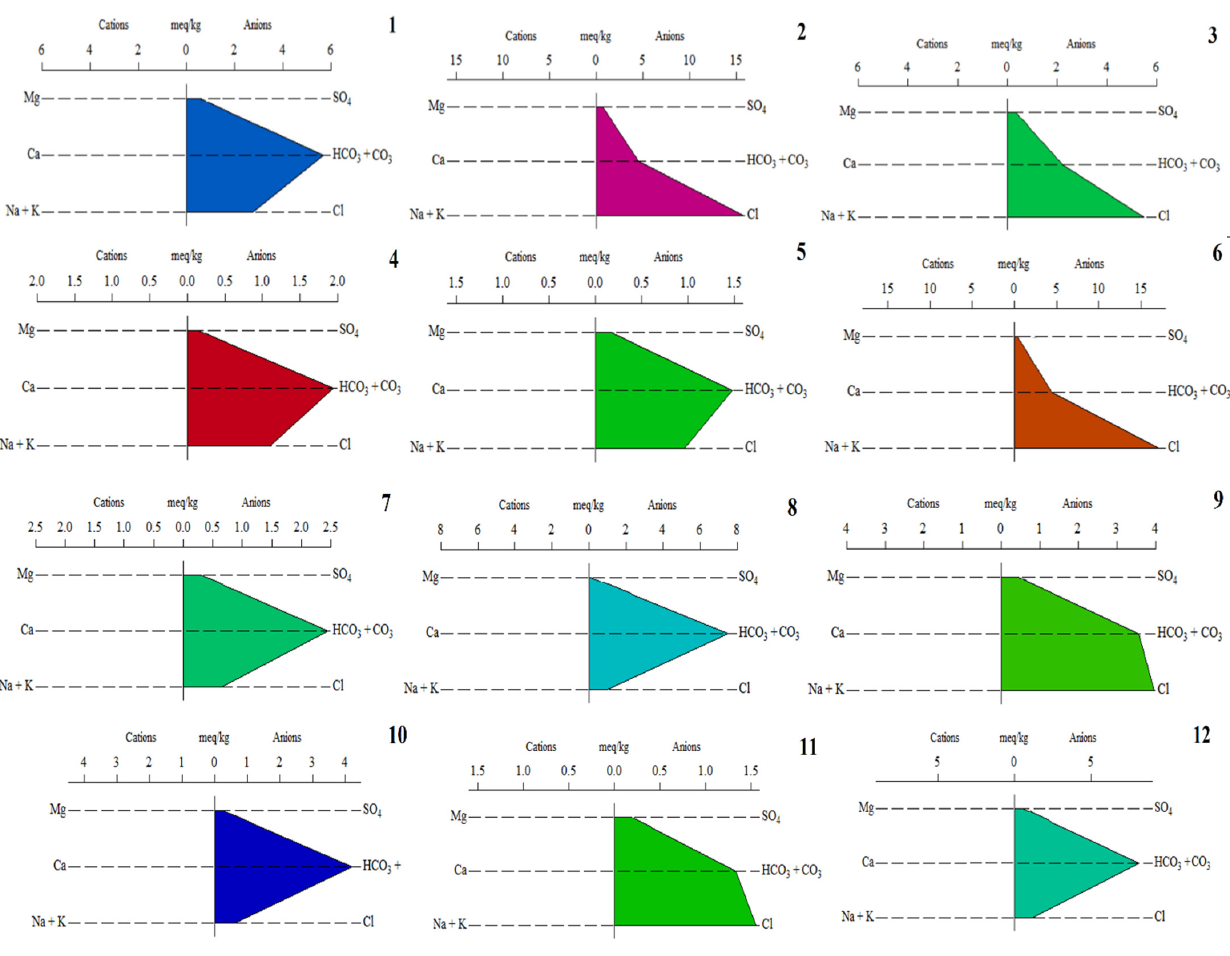
Figure 4. Stiff diagrams for all water samples (1–12).